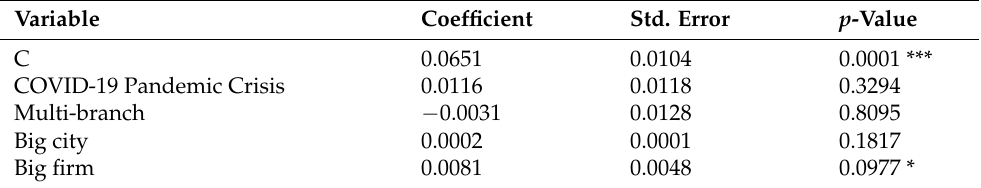
Table 11. The results of the eleventh research model.